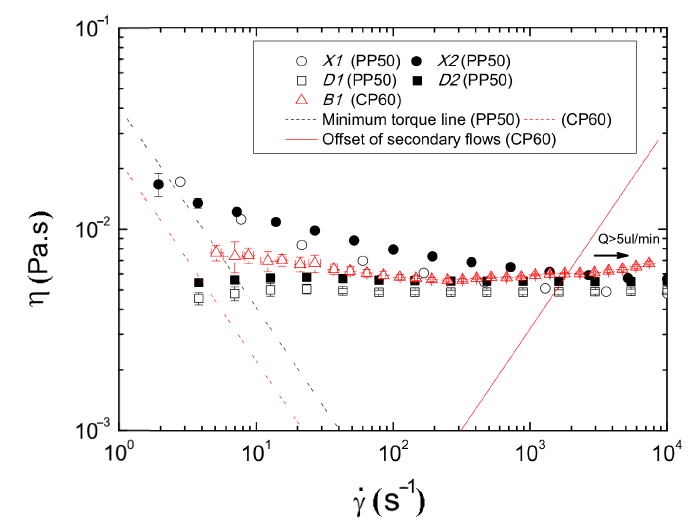
Figure 4. Steady shear viscosity curves for the viscoelastic solution with and without PMMA particles and for the Dx40 solution. The minimum torque line represents the limit of accuracy of the